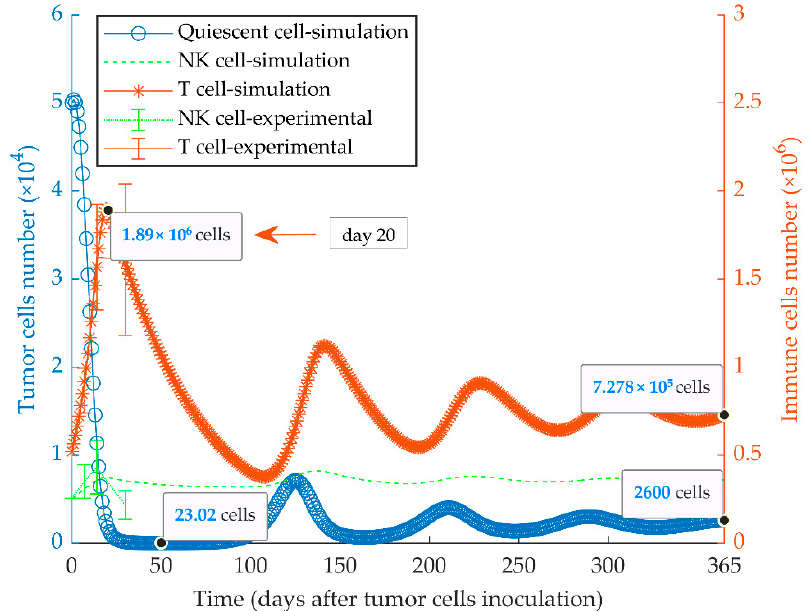
Figure 3. Mathematical simulation of growth of a quiescent tumor. By simulating the injection of 5 × 10 4 quiescent tumor cells (MR20) in immunocompetent mice, the tumor oscillates around low cell numbers and remains dormant for at least a one-year period. The size of the CD8 + T and NK effector cell populations oscillates with a delay lagging tumor cell oscillation. The left and right y -axes indicate the number of tumor cells and immune cells, respectively. Experimental data are from Reference [51] and are represented as mean ± SEM.